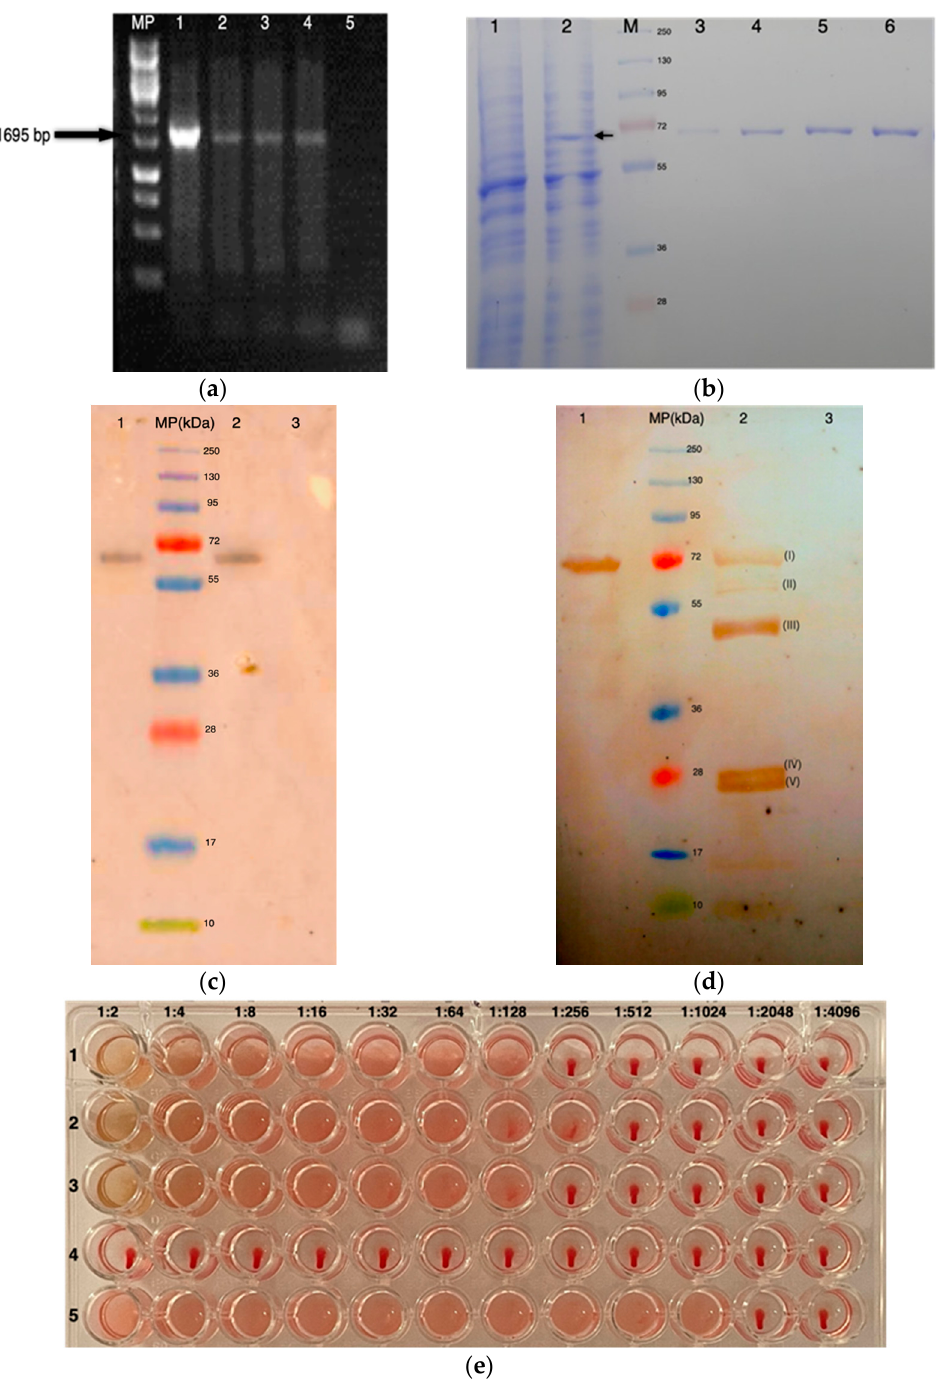
Figure 1. ( a ) One percent agarose gel to show PCR products corresponding to the H5HA gene of 1695 bp: lane 1, positive control (plasmid DNA with the gene H5rD ); lanes 2–4, PCR product from 3 samples from transformed D. salina culture; lane 5, negative control (DNA from 1 culture sample of untransformed D. salina ); MP, molecular weight marker (GeneRuler 1 kb DNA Ladder SM0311, Thermo Fisher, Waltham, MA, USA). ( b ) Coomassie blue-stained 12% SDS-PAGE gel showing the expression of a putative protein in transformed D. salina cultures: lane 1, TSP of WT D. salina cultures; lane 2, TSP of transformed D. salina cultures (adjusted to 70 μ g); lane MP, molecular weight marker (PageRuler™ Plus Prestained Protein Ladder, 10 to 250 kDa 26619, Thermo Fisher, Waltham, MA, USA); lanes 3–6, BSA at total concentration of 0.1, 0.5, 1, and 1.5 µ g, respectively. ( c ) Western blot